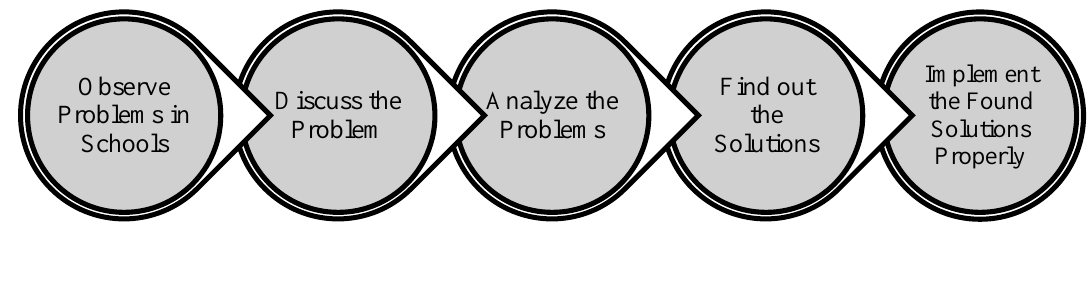
Figure 1. Flow Chart of